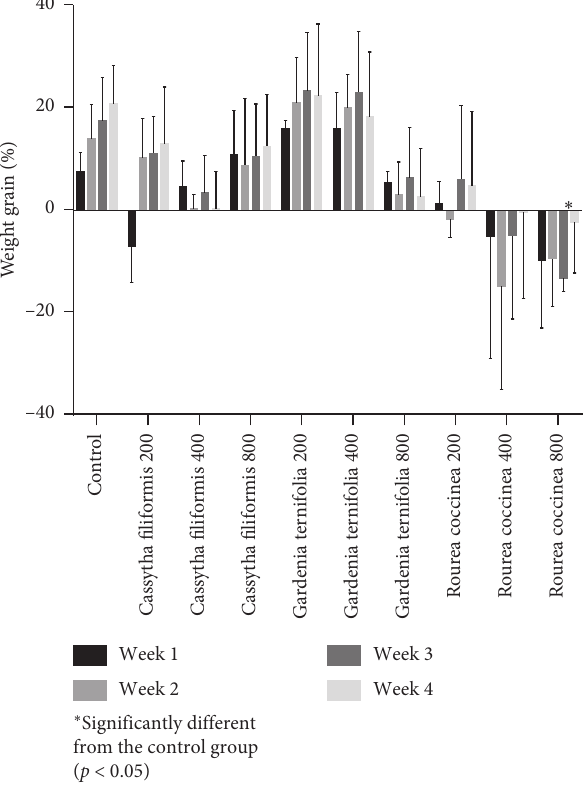
Figure 3: Evolution of animal bodyweight during the experimental